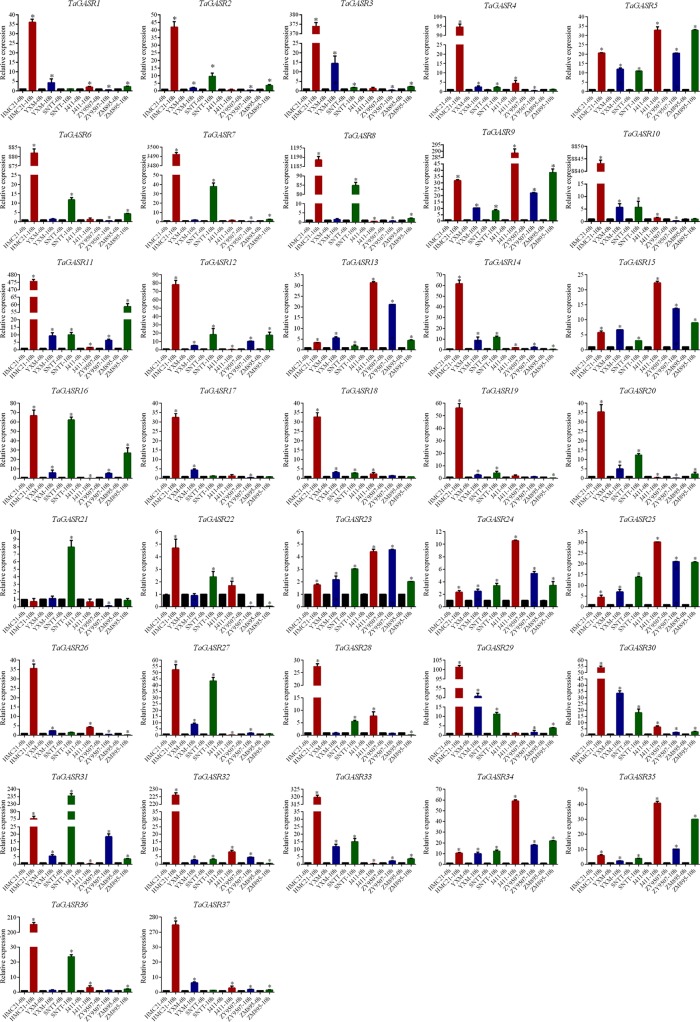
Expression patterns of 37 TaGASR genes during seed imbibition in six wheat varieties. Y-axis: relative expression; Error bars indicate 6 ± SE. *Statistical analysis of materials and methods has been labeled.